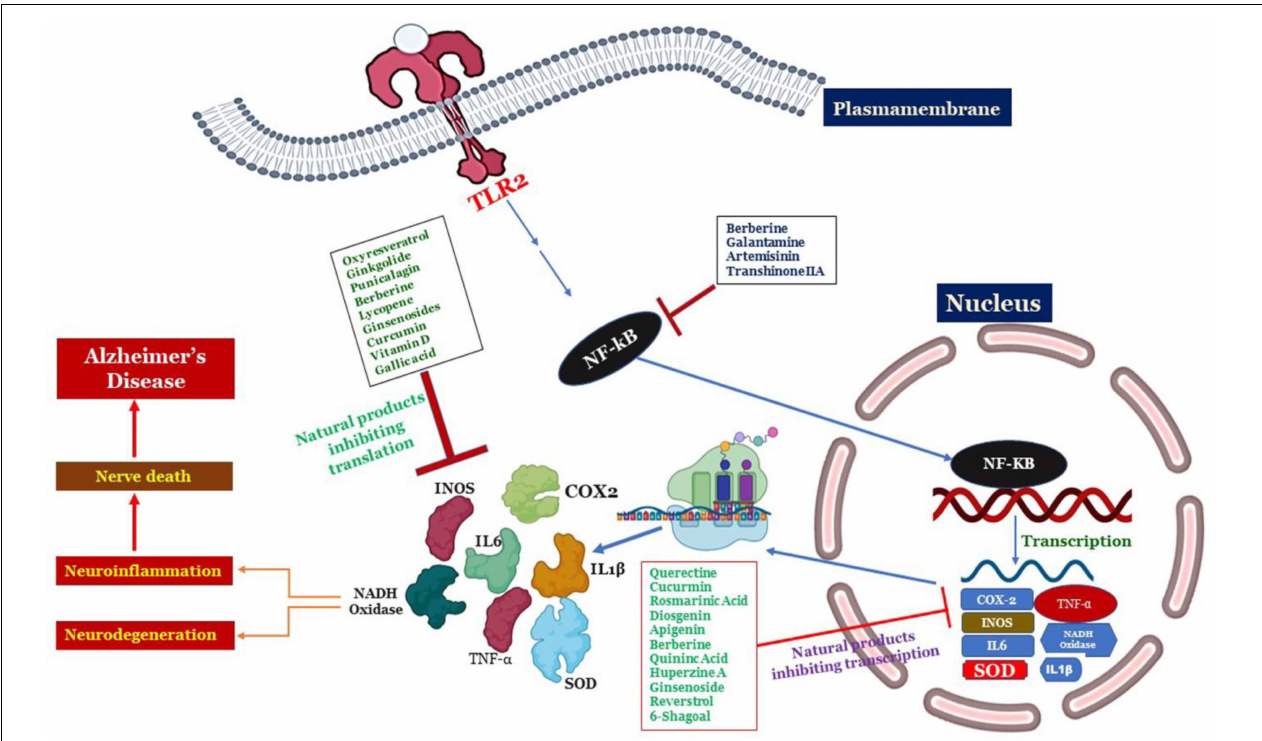
FIGURE 6 | Schematics showing the activation of signaling pathways responsible for clinical features of AD through TLR signaling cascades largely governed by NK-KB resulting in the neuroinflammation and nerve degeneration. On the other hand the novel intervention of natural products such as Diosgenin, Prosapogenin III, Quercetin, Apigenin, Ginsenoside Rg3, Rosmarinic acid, Ginkgolide B, Limonoid, Quinic acid, Curcumin, Resveratrol, Berberine, 6- Shagoal, Ligraminol E4-O- β -d-xyloside, Huperzine A, Sophocarpidine, Naringenin, Epigallocatechin-3-galate (EGCG), Oxyresveratrol, α -Mangostin, Galantamine are shown to inhibit this signaling cascade at the junction of NK-KB, and then inhibition of transcription as well as translation of proteins responsible for neuroinflammation.